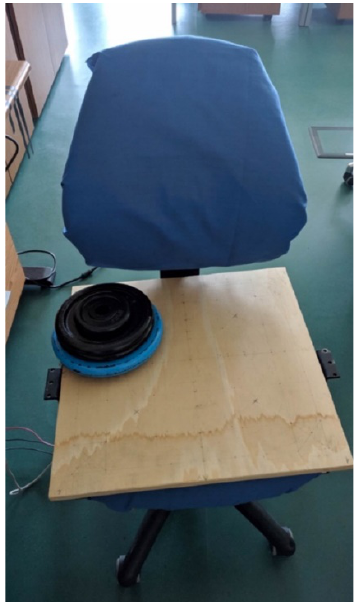
Figure 4. Load cells calibration setup performed using a graduate reference surface positioned on the chair LP and known loads.